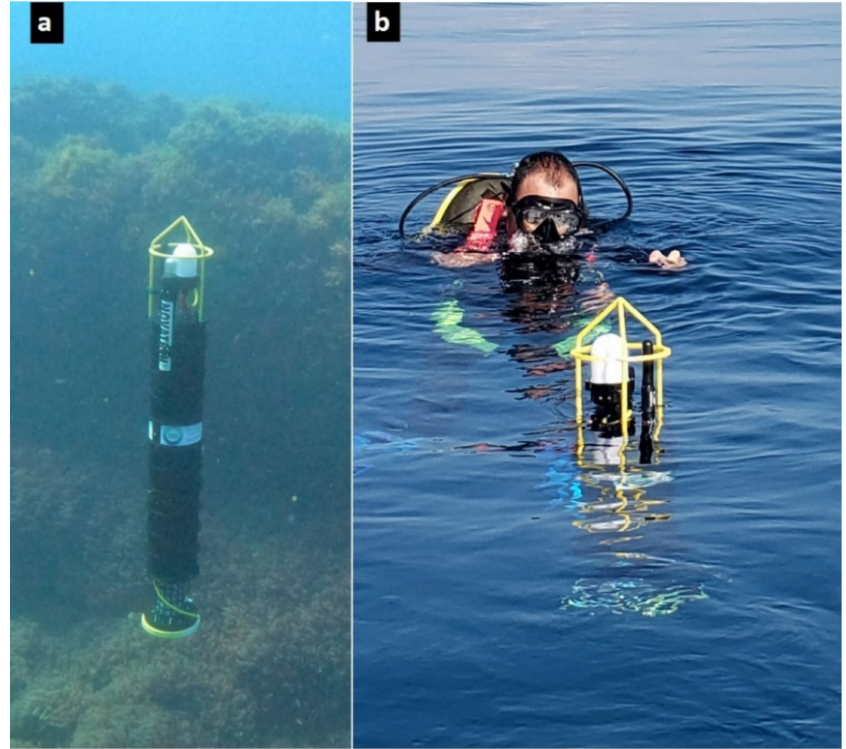
Figure 21. Sea trial: ( a ) during first deployment; ( b ) surfacing after first